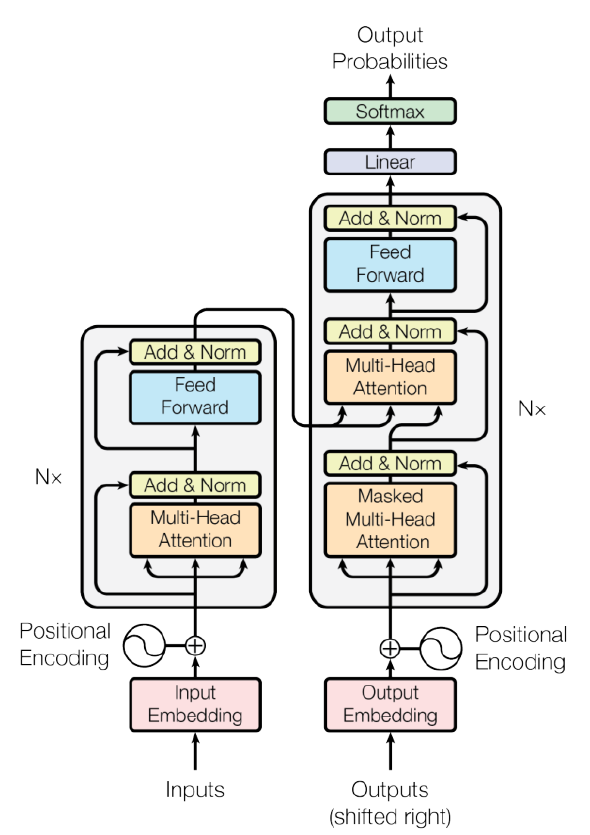
Figure 5. Transformer structure.